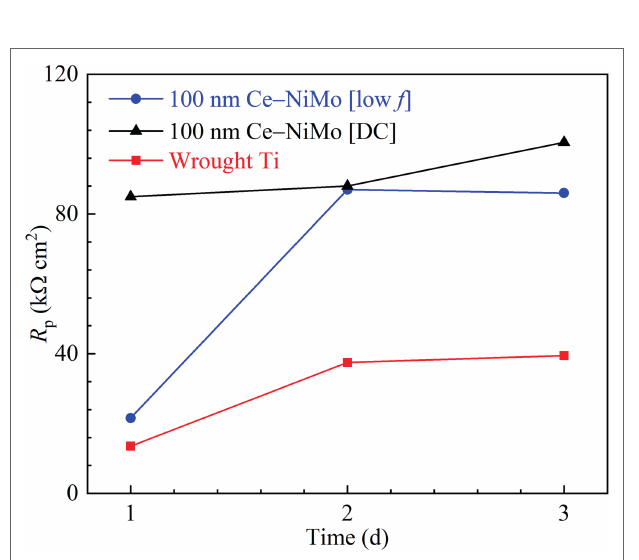
FIGURE 8 | Variations of R p vs. time during 3-day SRB incubation in 450 ml glass cells.